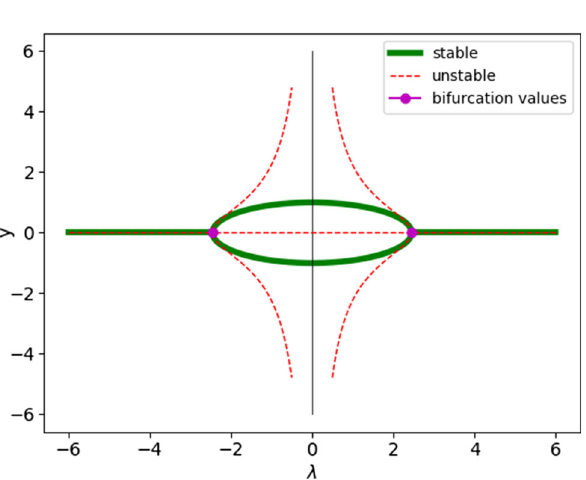
Fig. 12 Bifurcation diagram of the local stability of points P 1 to P 6 for α = − 3